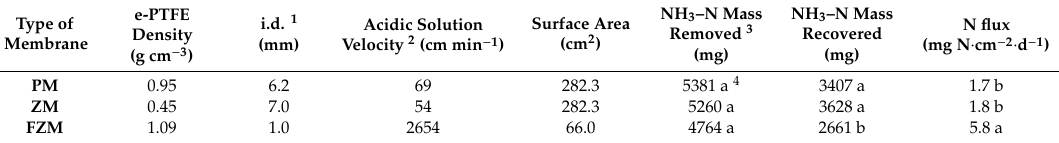
Table 3. Mass of NH 3 –N removal, NH 3 –N recovered by gas-permeable membranes, and N-flux with varied polymer density, surface area, and acidic solution velocity (experiment